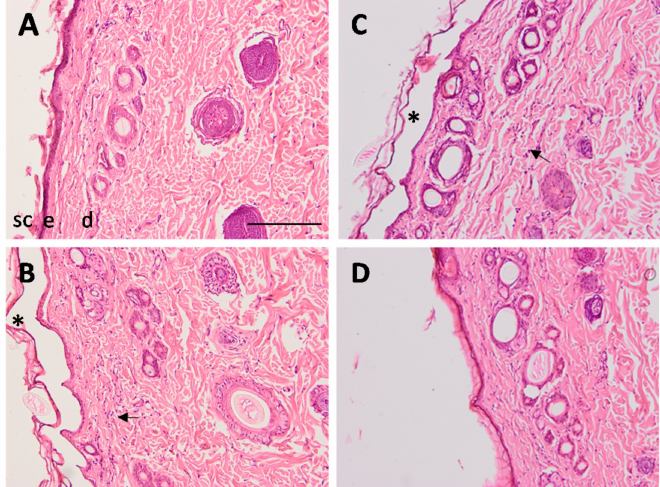
Figure 10. Representative histological sections (original magnification, × 100) of rats’ skin in control conditions ( A ) and after 1 h treatment with xylol; without treatment ( B ), treated with the formulation without active ingredient ( C ), and treated with PF-NLCs-F127 hydrogel ( D ) stained with hematoxylin and eosin. Skin structures: sc, stratum corneum; e, epidermis; d, dermis; * indicates the loss of stratum corneum and the arrow indicates the infiltration of leukocytes. Scale bar = 100 µ